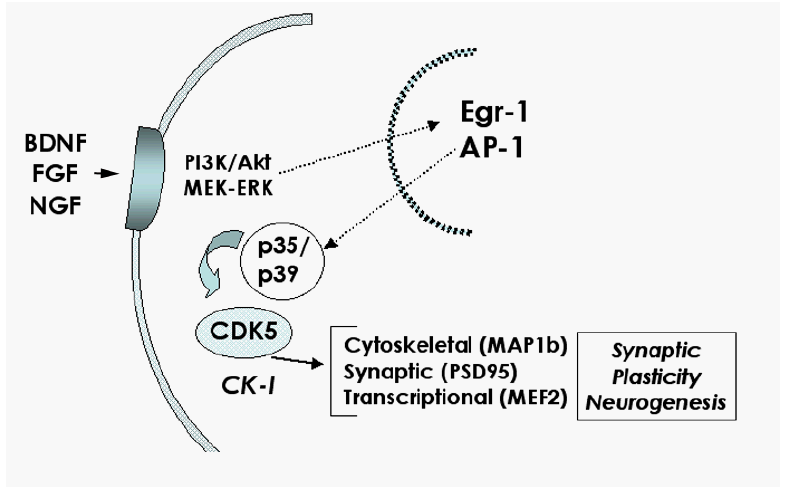
Figure 5. Physiological role of p35-CDK5 signaling in neurons. In the brain, CDK5 is